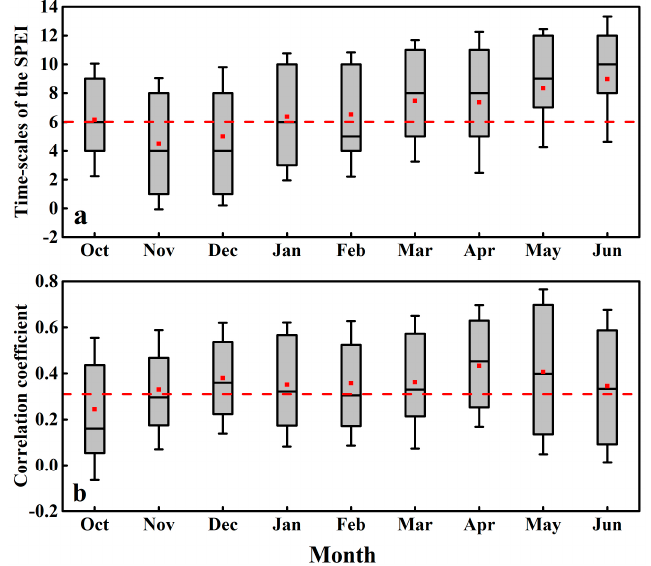
Figure 7. Box plot: ( a ) the time ‐ scales of the SPEI which have the highest correlation coefficients with the winter wheat yield from October to June at each station. The red dotted line represents the 6 ‐ month time ‐ scale SPEI, the red point in figure a represents the mean value of the time scales of drought. ( b ) The highest correlation coefficients from October to June at each station between winter wheat yield and SPEI. As the simulation length is 33 years, the values of 0.35 are responses to 5% significant levels of those correlation coefficients (the red dotted line). The red point in ( b ) represents the mean value of the correlation coefficients.